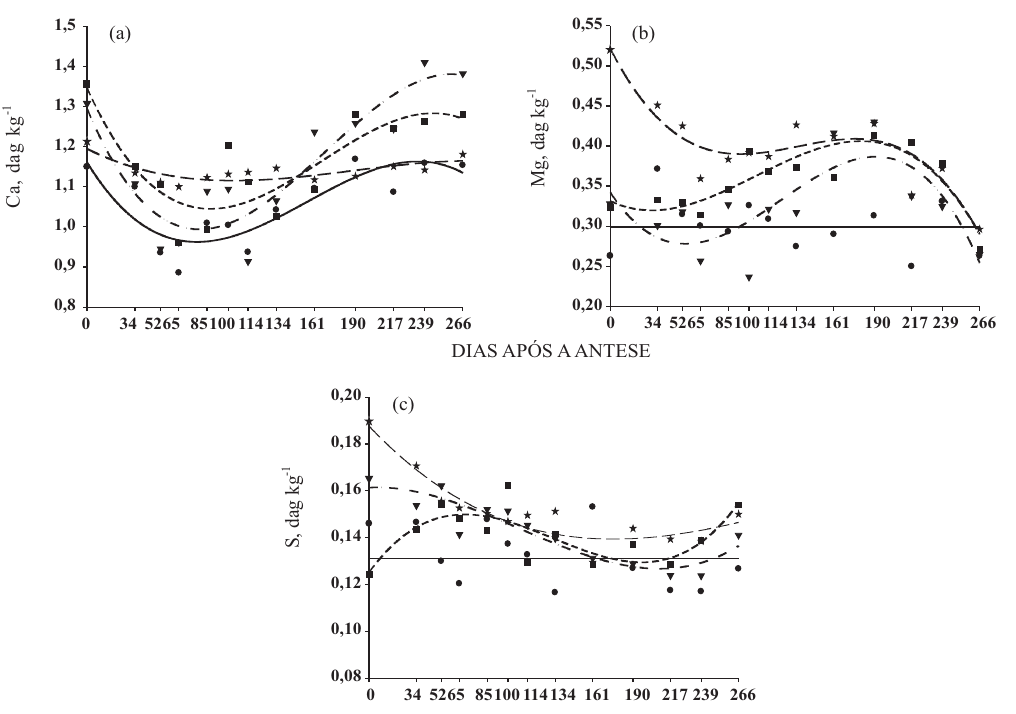
DAA)Figura 2. Concentração de Ca (a), Mg (b) e S (c) em folhas de cafeeiro em função do tempo decorrido após a antese, em quatro